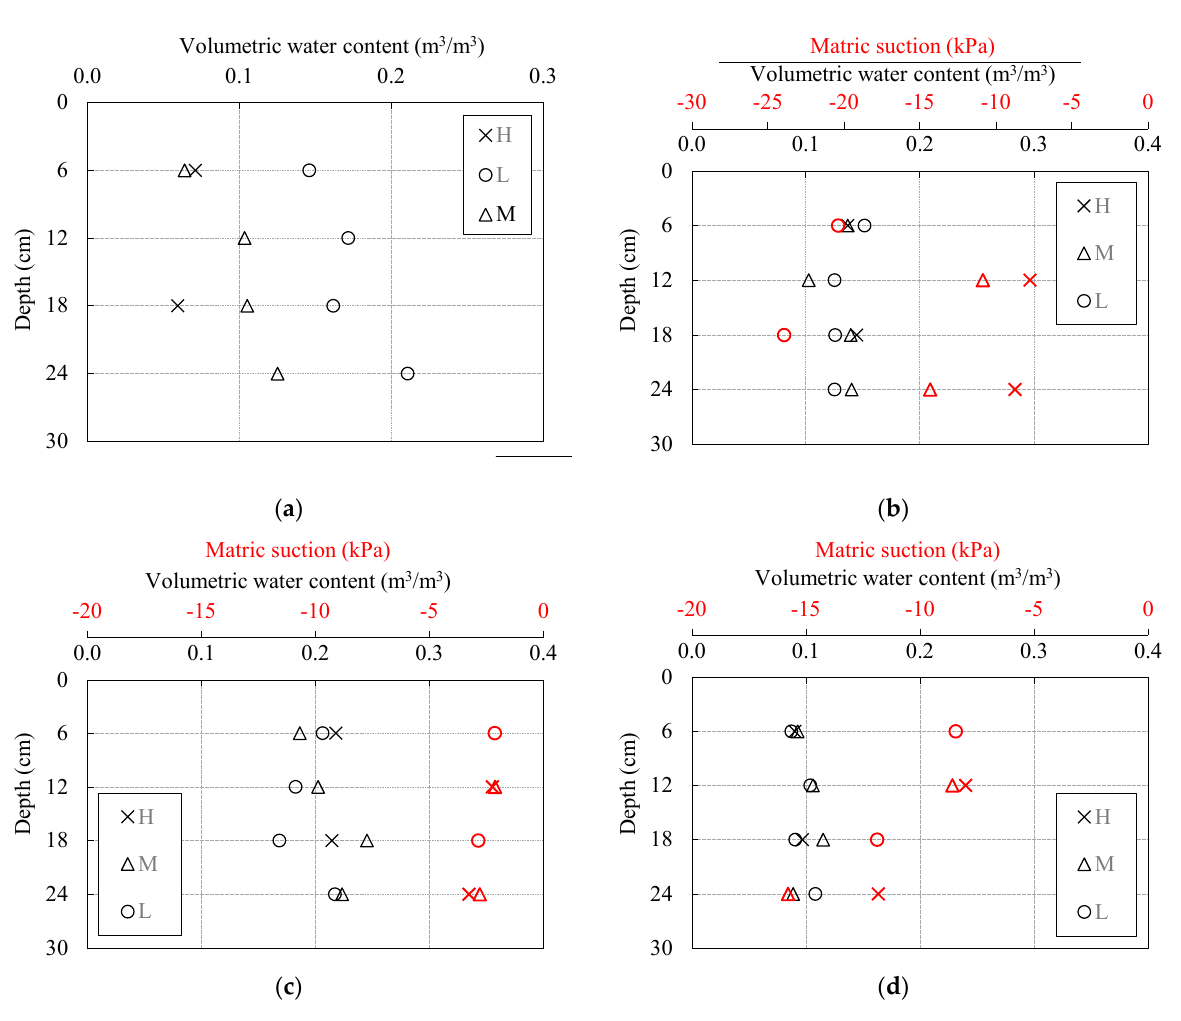
Figure 14. Initial volumetric water content and matric suction distributions along the upper (H), middle (M) and lower (L) measurement profiles for tests on 35-degree inclined slope models built in: ( a ) clean sand; ( b ) SK15; and SK10 with higher ( c ) and lower initial soil moisture contents ( d ).